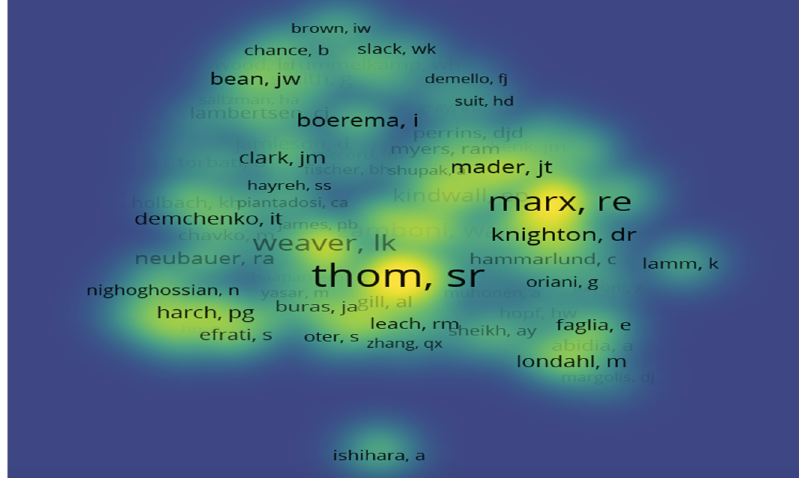
Figure 5. Visualization of co-citation density.